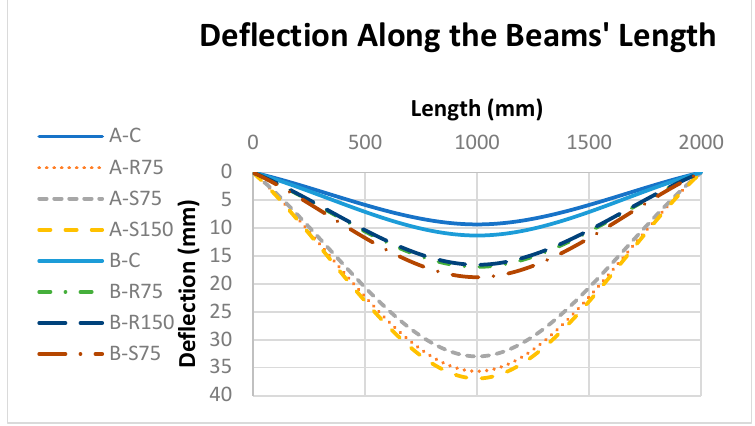
Figure 8. Deflection along the beam length.